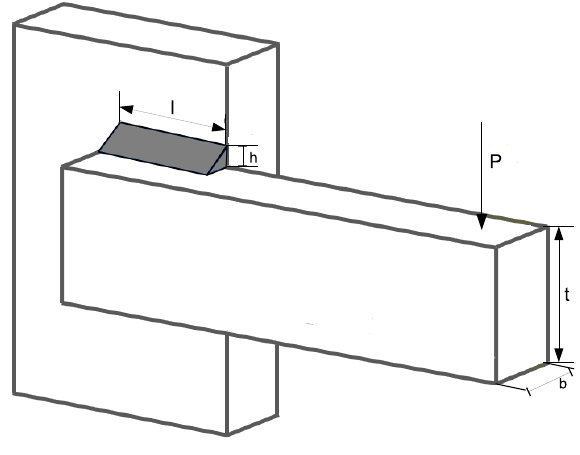
Figure 9. Welded beam design